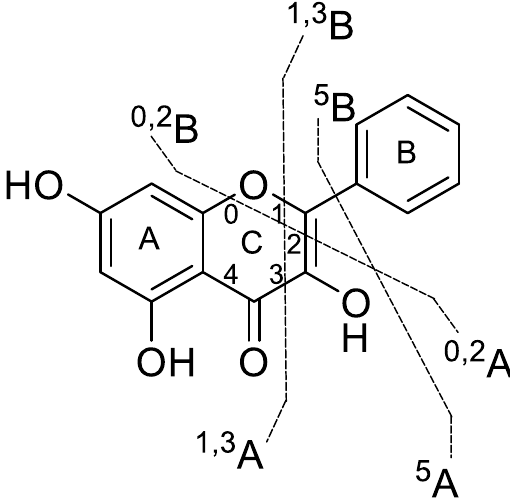
Figure 3. Typical cleavage pattern for galangin.